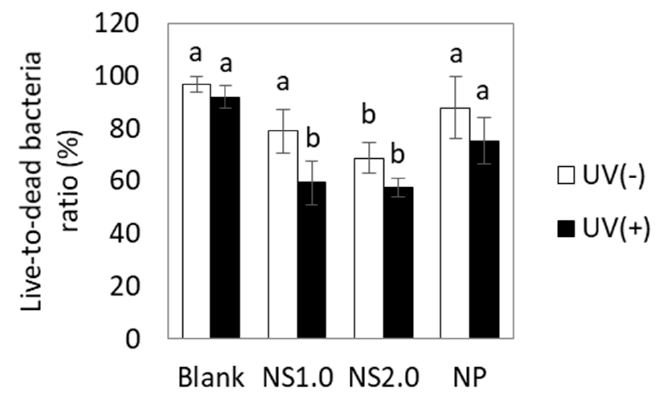
Figure 7. Live-to-dead bacteria ratio. Different letters in the same material groups show significant differences ( p < 0.05).